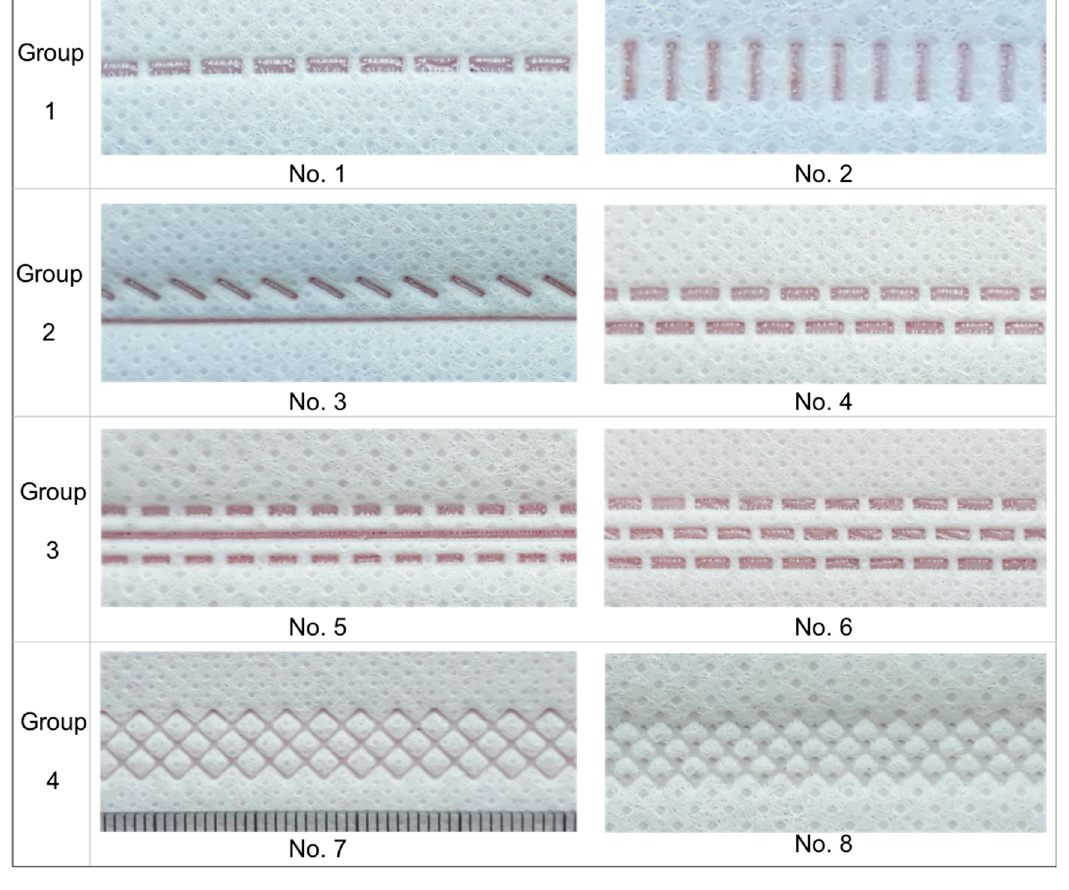
Figure 6. The welding joint images of the eight patterns (No. 1–No. 8). Appl. Sci. 2020 , 10 , x